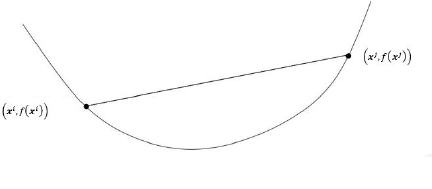
Figure 10. Graph of a convex function. The chord (i.e., line segment) between any two points on the graph lies above the graph.